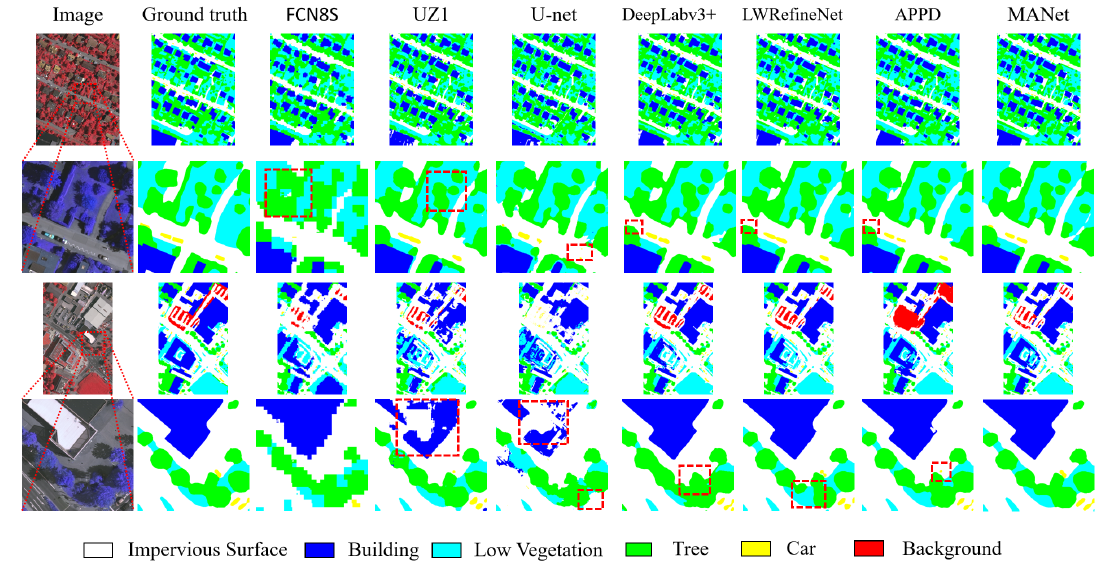
Figure 8. Visual comparison of seven models on the Vaihingen